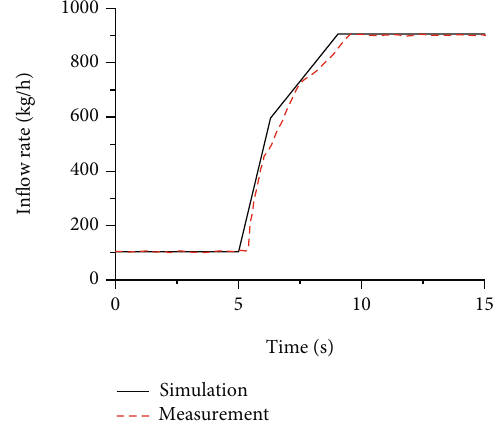
Figure 18: Comparison between the simulated and measured data of cabin in fl ow rate.